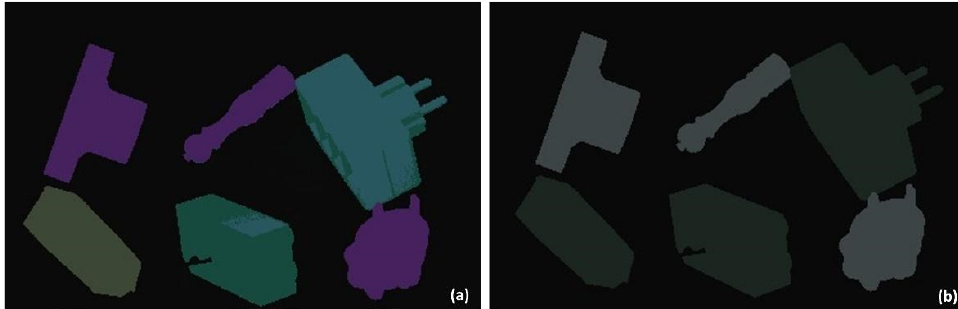
Figure 5. Two steps clustering. ( a ) After first clustering few objects are identified as multiple clusters; ( b ) After second clustering all objects are identified as single clusters.